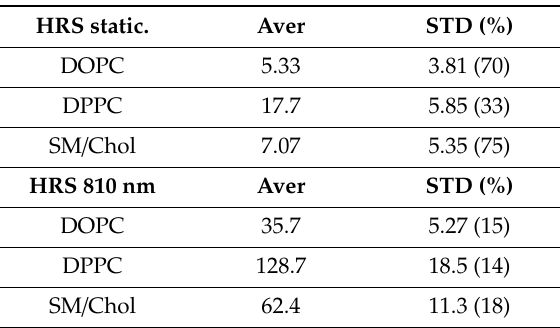
Table A4. Average values and standard deviations (STD) for the static and dynamic HRS signals (in 10 − 30 esu). The relative STD is given in